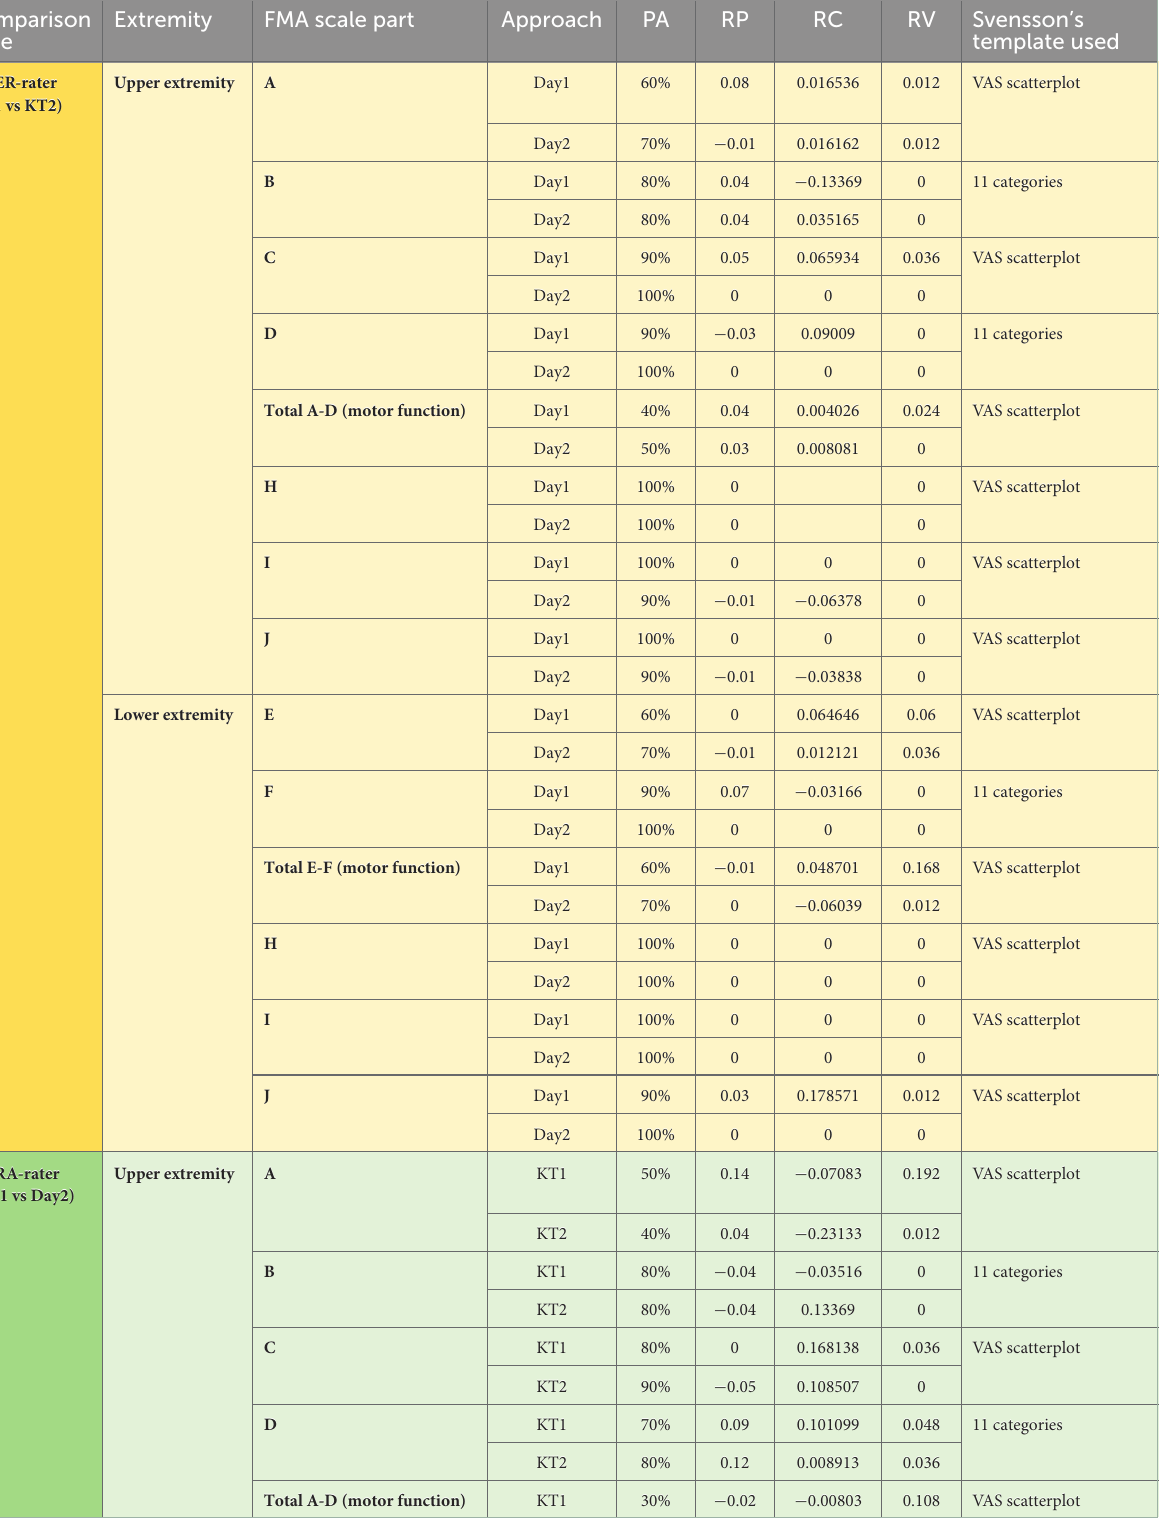
Svensson’s template used